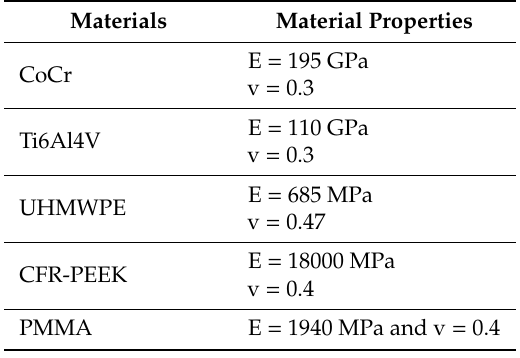
Table 2. Material properties for the implanted